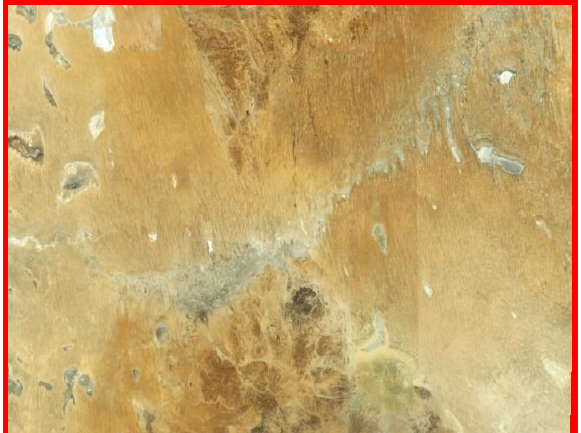
Figure 3. Image is an enlargement of the study site located in Figure 2. The major feature running from the upper right to centre left of the image is Cooper Creek which runs into Lake Eyre being located outside the study area to the left. Image is from Google Earth.